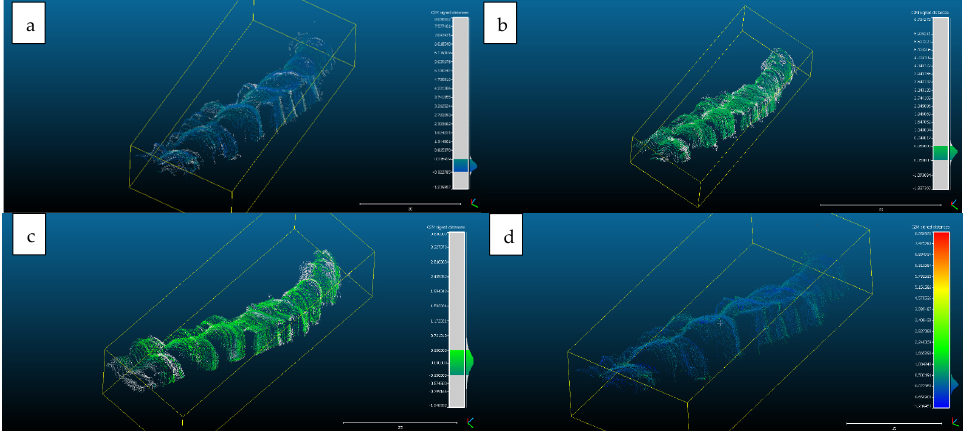
Figure 9. Distribution of the alignment distances/errors of the 3D ultrasonographic points from the scanned reference object after alignment in CCOSS: ( a ) Scan 2—aligned with STL reference object. The farthest points are colored in gray, alignment errors are evenly distributed along the scanned object (observe the blueish distances’/errors’ distribution on the righthand side of the figure); ( b ) Scan 3—aligned with the reference STL object (observe the greenish distances’/errors’ distribution between the 3D points and reference object on the righthand side of the figure); ( c ) Scan 4 aligned with STL reference object (3D points distances’/errors’ spatial distribution in green on the righthand side of the figure); ( d ) Scan 5—aligned with STL reference object (3D points distances’/errors’ spatial distribution in blueish on the righthand side of the figure).